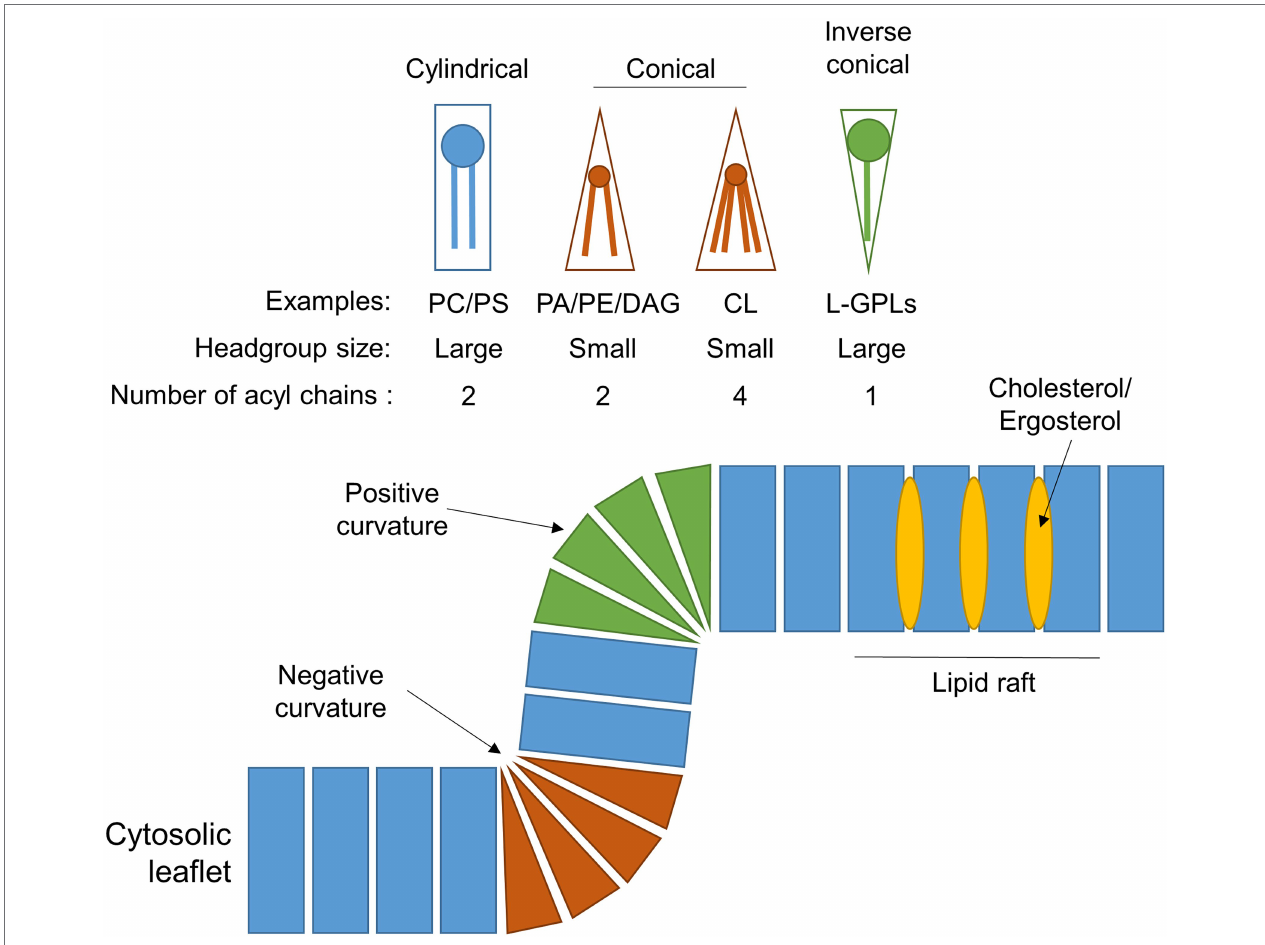
FIGURE 2 | Phospholipid composition shapes the peroxisomal membrane. Schematic showing the different geometries of individual phospholipids, which depends on the size of their head group and/or number of acyl chains. The incorporation of these differently shaped phospholipids into a membrane leaflet will cause the membrane to adopt a positively-curved, negatively-curved, or planar topology, depending on the lipid species. The insertion of cholesterol (in mammals) or ergosterol (in fungi) into the hydrophobic region of the membrane generates lipid rafts with unique biophysical properties. For simplicity, only the outer leaflet of the peroxisomal membrane is shown. Examples: CL, cardiolipin; DAG, diacylglycerol; L-GPLs, lysoglycerophospholipids (e.g., LPA); PA, phosphatidic acid; PC, phosphatidylcholine; PE, phosphatidylethanolamine; and PS,